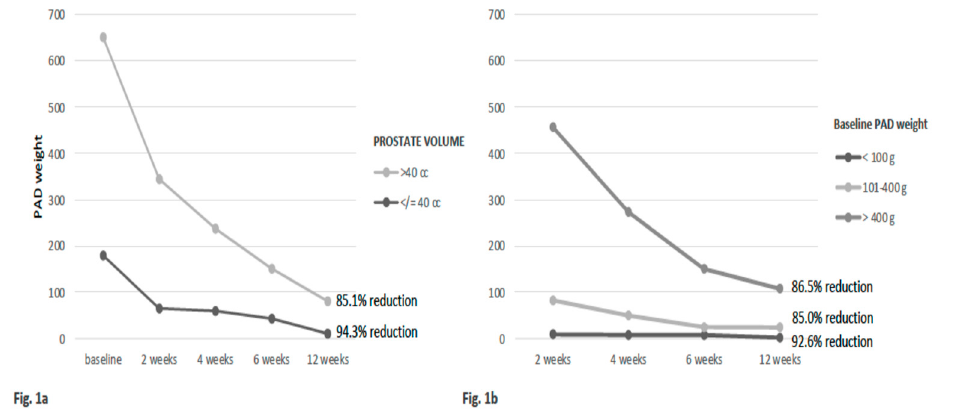
Figure 1. Pad weight variation (mean values) from baseline to 12-week follow-up according to ( a ) prostate volume (PV) and ( b ) baseline pad weight stratification. One-way ANOVA ( p < 0.01); measurements (338 × 190 mm (150 × 150 DPI)). Table 2. Comparison of characteristics of the population submitted to pelvic floor rehabilitation for urinary incontinence after radical prostatectomy on the basis of pad-free results at 3-month follow- up